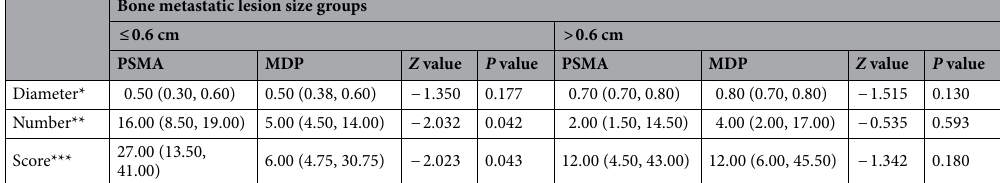
Table 4. Number of clinical bone metastases and degree of imaging agent uptake observed under 99m Tc-PSMA and 99m Tc-MDP. *Maximum diameter of bone metastatic lesion expressed in cm. **Number of bone metastatic lesions. ***Total score of bone metastatic lesion